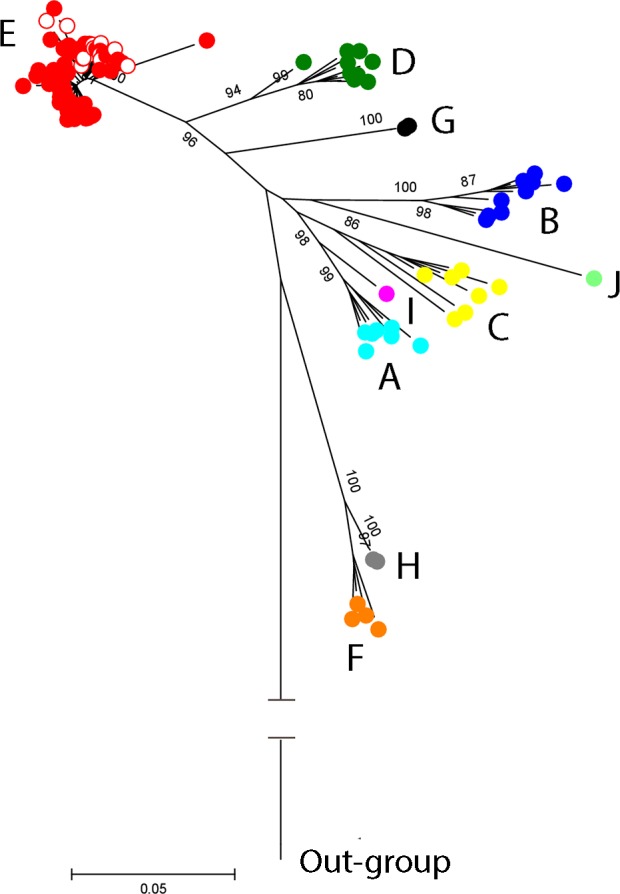
Phylogenetic reconstruction of world-wide and Offin river valley HBV sequences based on the pre-S/S region.A maximum-likelihood phylogenetic tree of HBV pre-S/S sequences obtained in this study (red dots) together with publically available sequences covering all HBV genotypes (multicolored dots) was constructed with 1000 bootstrap replicates using the Kimura 2-parameter +G +I model [41] contained in MEGA6 [42]. The tree is drawn to scale, with branch lengths corresponding to the number of substitutions per site. Reference sequences retrieved from GenBank are for genotypes A (AY233278, HE576988, AM184126, AM180623, FJ692609, GQ331047, FN545833), B (AB073842, AB073836, AB033555, AB100695, AB219427, DQ463789, EF473977, AP011093, GQ358145), C (AF223954, AB033556, X75656, AB048704, AB241109, AP011102, AP011104), D (JF754615, EU594428, AY233291, KF192838, GQ205378, AB493846, FJ904430, FN594771, JN664919), E (circles without fill: AB205192, AB106564, DQ060830, AB201290, AB205188, AB091255, AB091256, HM363611, FN594765, AB205191, AB205190), F (AF223964, X69798, AB036914, DQ823087), G (AB056513, EF634480), H (EU498228, EF157291), I (FJ023660), and J (AB486012). The sequence of a Woolly monkey HBV was included as an out-group.